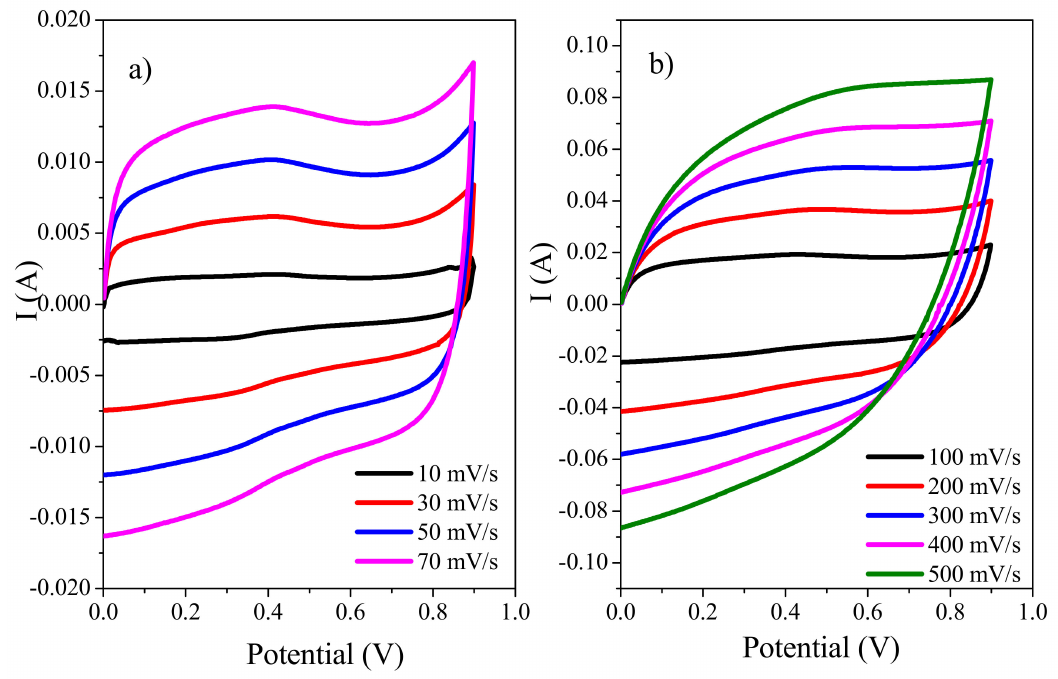
Figure 9. ( a ) CVs of a solid-state symmetric device (using gold as current collector) at various lower scan rates (10, 30, 50, and 70 mV / s) and ( b ) higher scan rates (100, 200, 300, 400, and 500 mV /